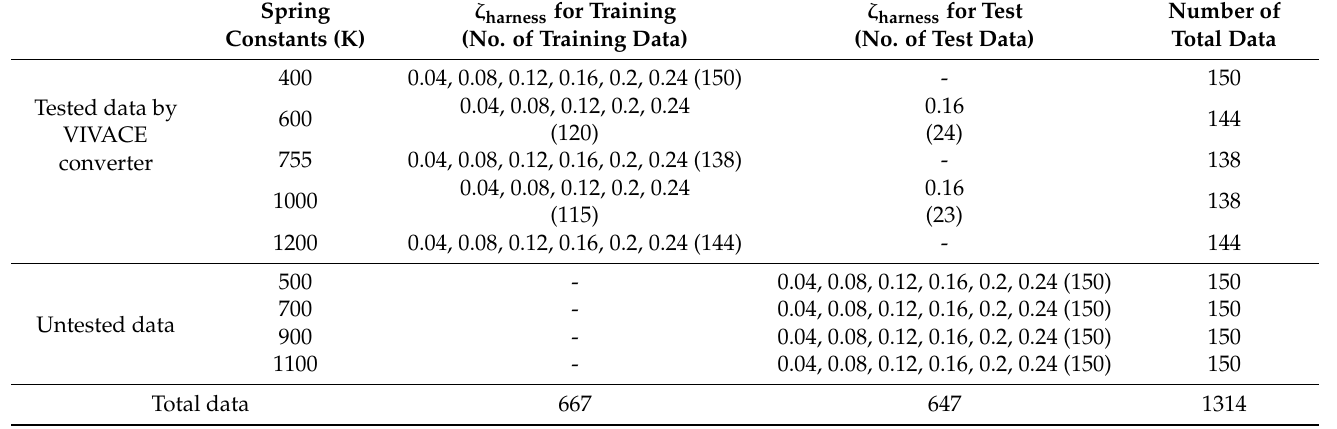
9 of 17 Table 4. Data classification for learning in deep learning models. Spring Constants (K)